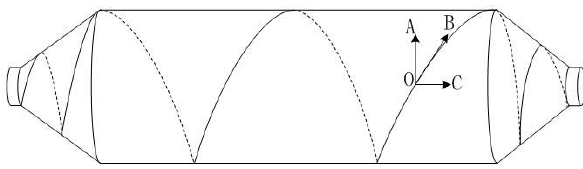
Figure 2: The sketch of helical winding